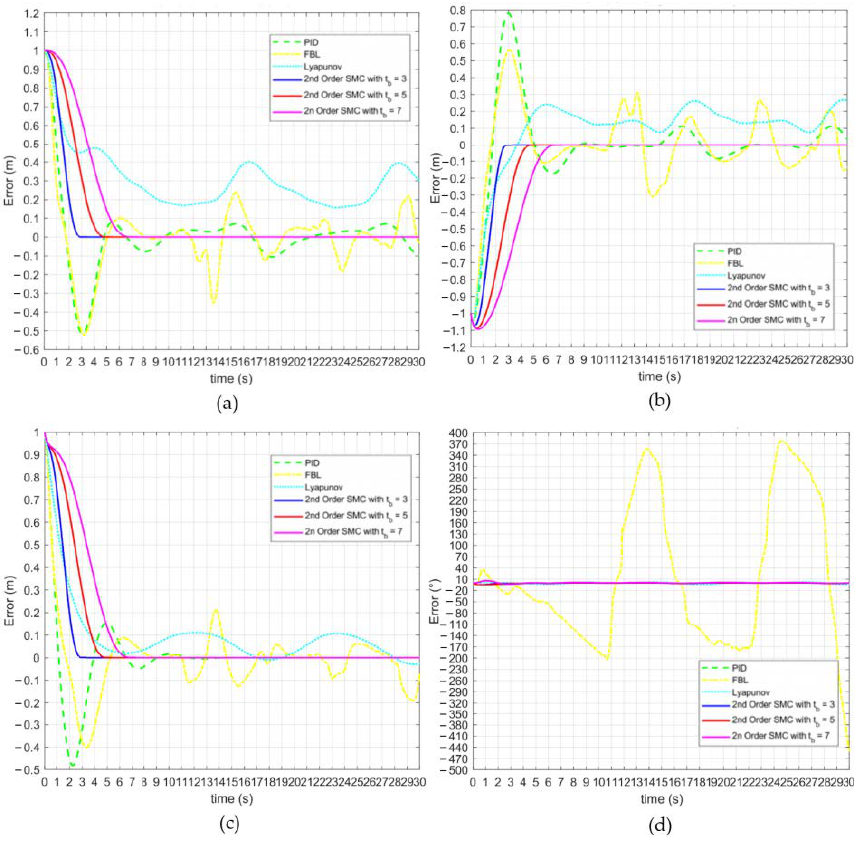
Figure 14. Error convergence for different controllers when subject to high ocean currents. ( a ) Surge error. ( b ) Sway error. ( c ) Heave error. ( d ) Yaw error.